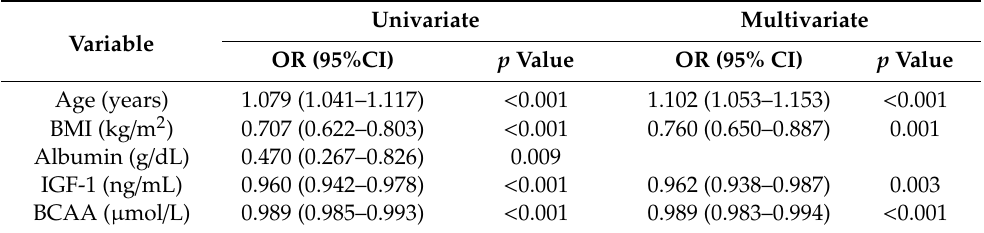
Table 2. Factors associated with sarcopenia in patients with liver